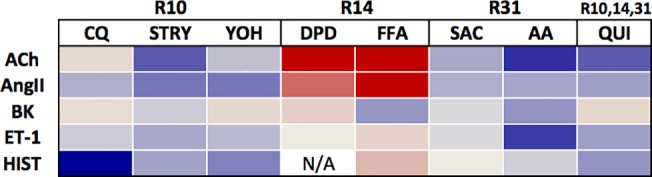
Heat map of the relative effects of TAS2R agonists on [Ca2+] stimulated by the indicated procontractile CPCR agonists.Data from the experiments in Fig 4 were normalized to maximal stimulation (red) or inhibition (blue). TAS2R agonists are on the top row and their subtype specificity shown. Procontractile GPCR agonists are listed in the first column. N/A, not applicable.